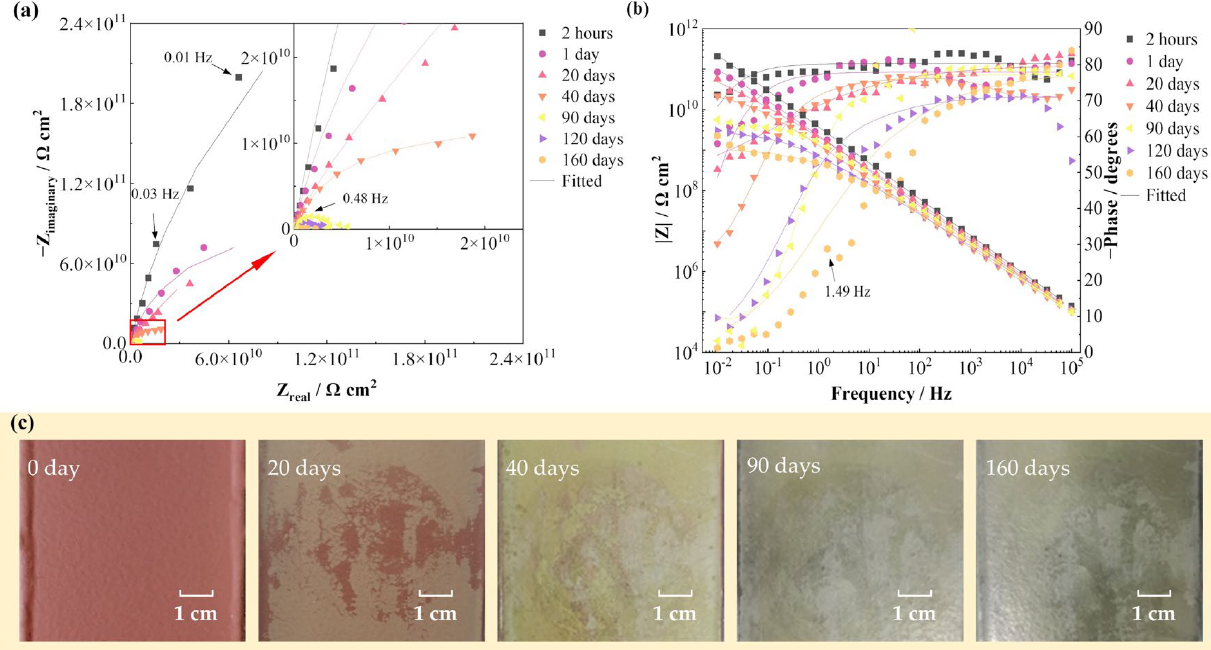
Figure 1. EIS spectra and surface photographs of the FW-1 coating sample in 160 d immersion test: ( a ) Nyquist plot; ( b ) Bode plot; ( c ) digital photos.